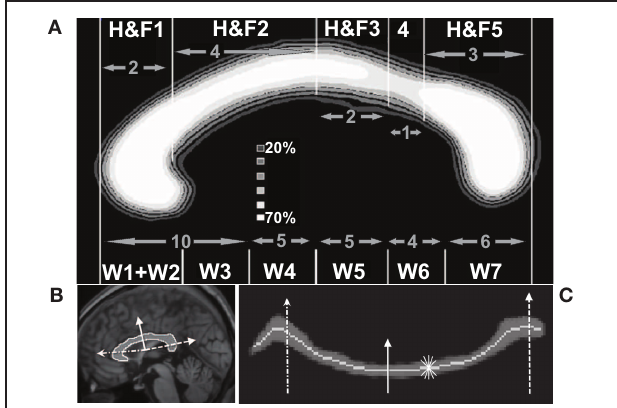
FIGURE 3 | Quantification of callosal area and thickness. (A) Average callosal structure of 152 young subjects from the OASIS database, averaged in MNI space. Each subject’s callosum was subdivided into five compartments along the anterior–posterior axis using geometric ratios following Hofer and Frahm (H&F, top of panel A ) (Hofer and Frahm, 2006) and divided into six compartments following Witelson (W, bottom of panel A ) (Witelson, 1989). (B) Callosal boundaries were defined with reference to a series of radial lines (three shown) emanating from a centroid. (C) Radial lines intersecting the callosum were oriented vertically. This unwrapped the callosum to define a median line and measure thickness. The same three lines intersecting the callosum in (B) are shown. The light gray line shows the median location of WM probabilities (dark gray) considered vertically. Callosal thickness was computed at each point using the shortest line segment connecting the superior and inferior surfaces through that point (five shown, short thin